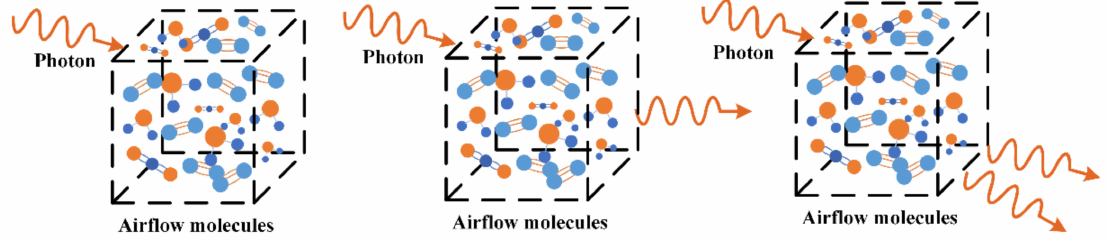
Figure 1. Absorption, scattering, and stimulated radiation of molecules in photon